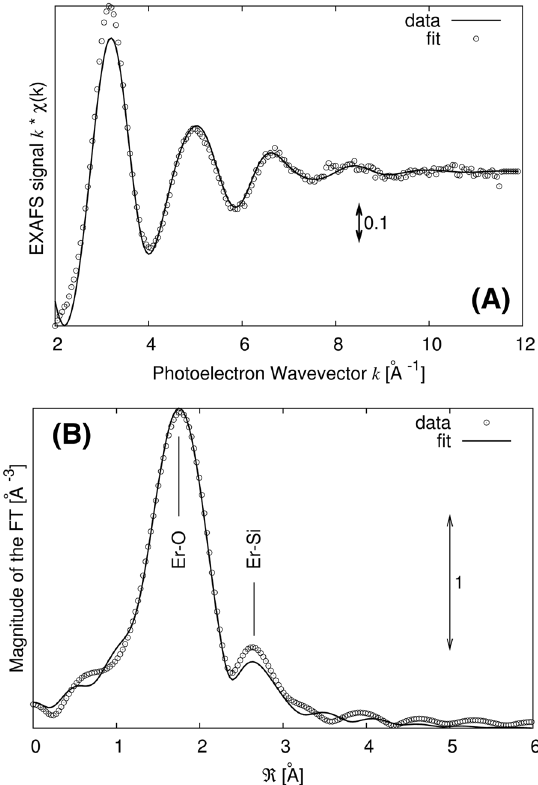
Figure 5. EXAFS measurements of a typical PSi_8%_A sample. ( A ) EXAFS spectrum and best fitting curve. ( B ) Fourier Transform of the EXAFS spectrum with the peak identification Er-O and Er-Si. Transforms were carried out in the interval K = 2.5–8 Å − 1 with a k 2 weighting factor.